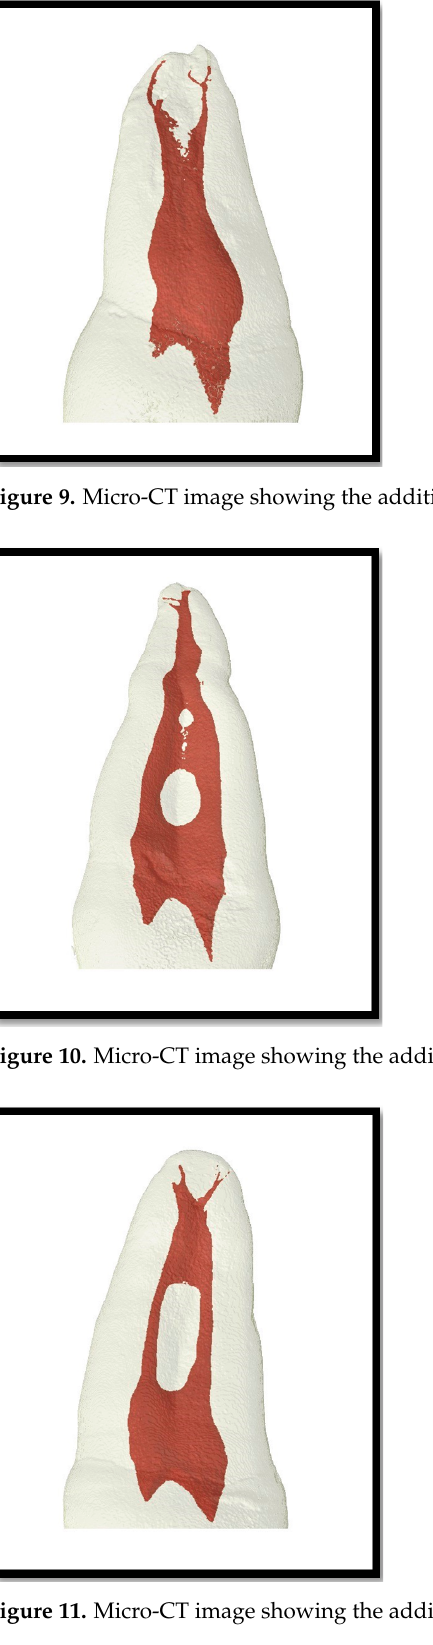
Figure 11. Micro-CT image showing the additional canal configuration